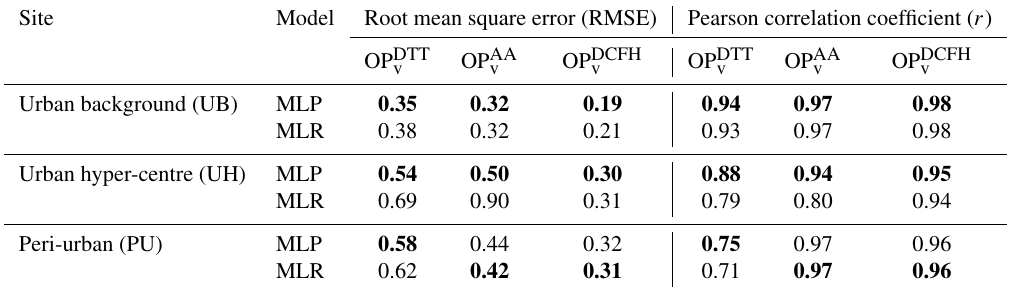
Table 1. The comparison of predictive accuracy of the observed OP activity between the MLR and MLP models based on root mean square error (RMSE) and Pearson correlation ( r ). Note: RMSE is ideally ∼ 0 (lower RMSE in bold), and r is ideally ∼ 1 (higher r in